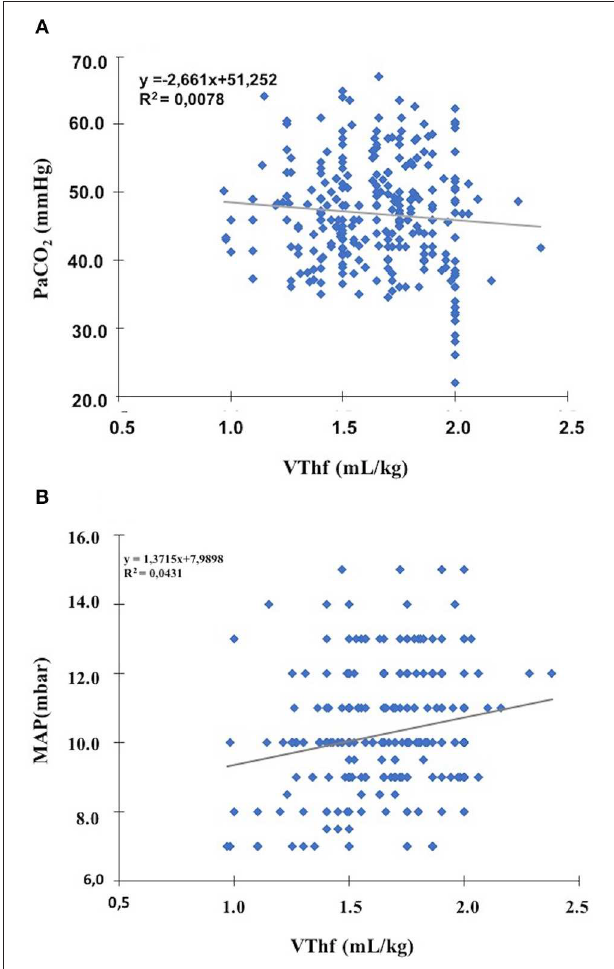
FIGURE 1 | Pearson correlation analysis between VThf, pCO 2 , and MAPhf levels (A) no significant correlation between all VThf and pCO2 levels (Pearson coefficient = 0.01, p = 0.899) (B) a very weak, but significant correlation between optimal VThf and MAPhf levels (Pearson coefficient = 317, p <